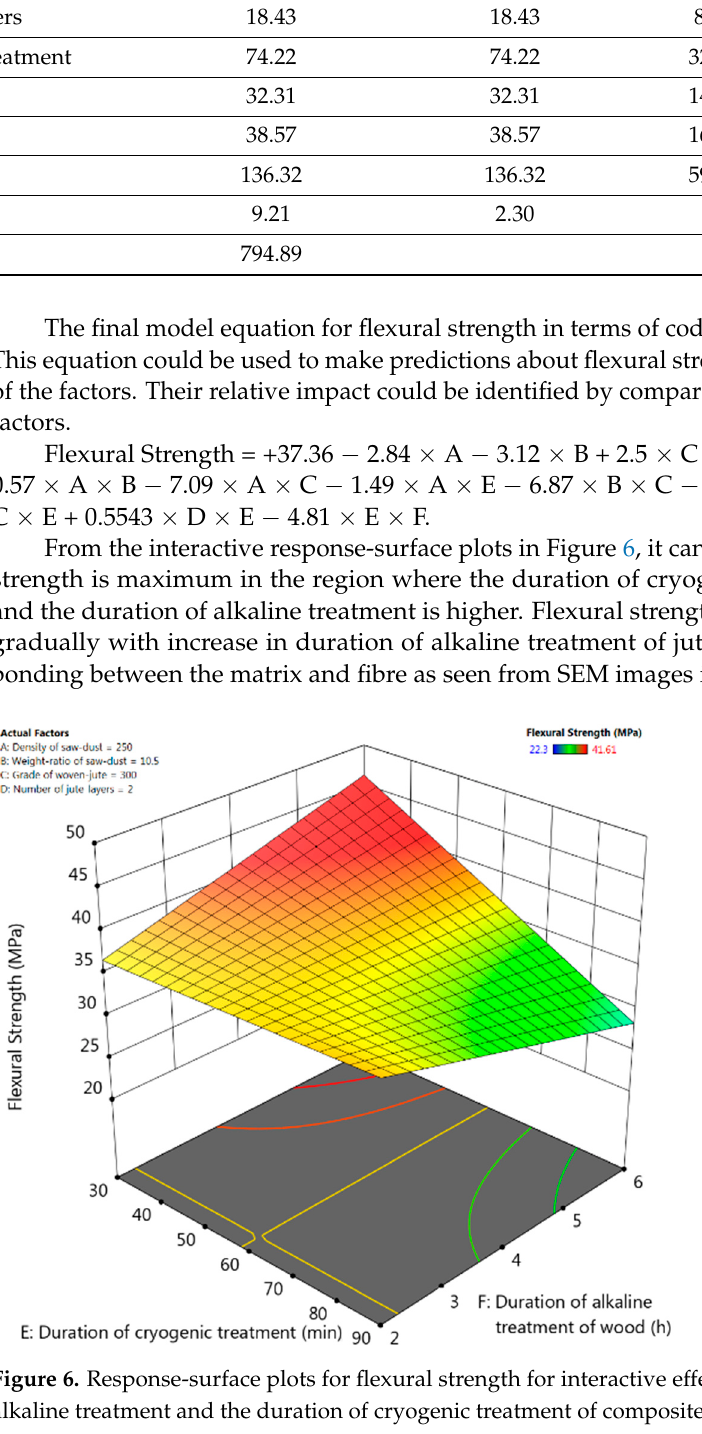
Table 4. Results of ANOVA for flexural strength including only the significant parameters. Source Sum of Squares Mean Square